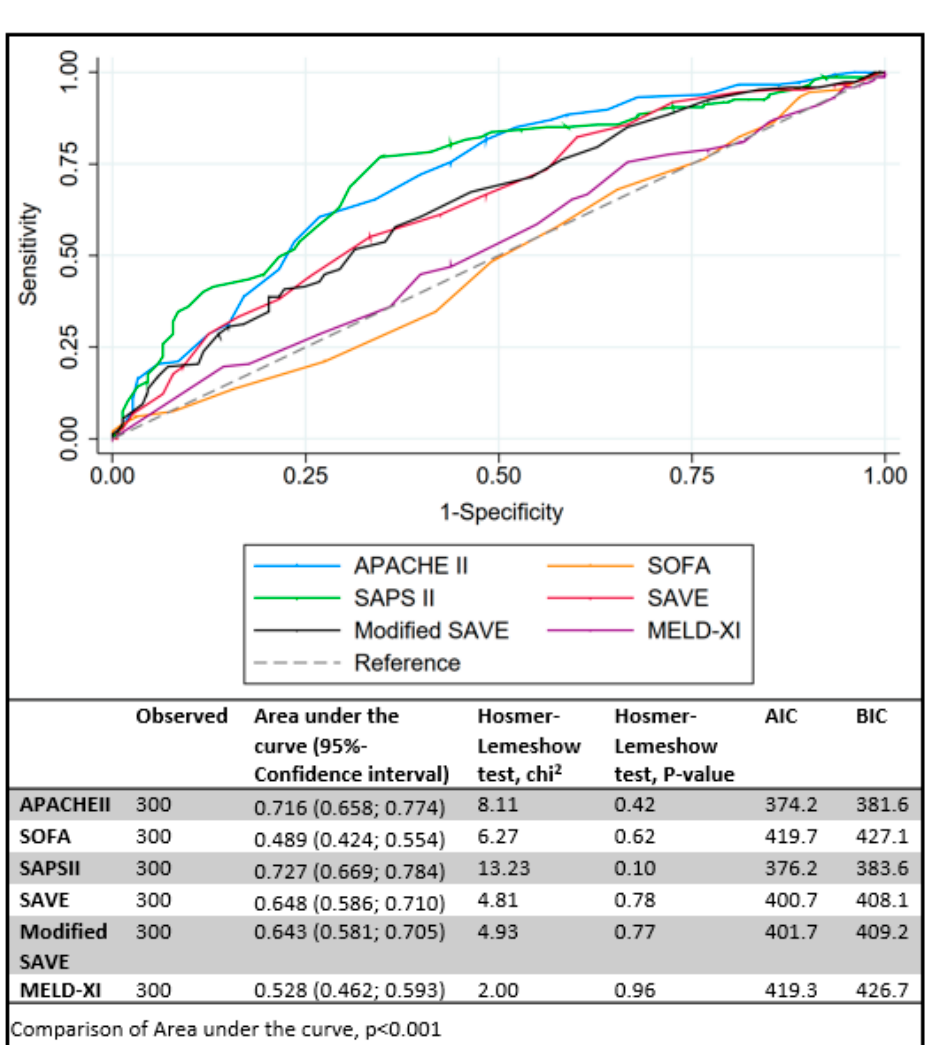
Figure 3. Comparison of area under the receiver-operating characteristics curve (AUC) for (A) veno-arterial extracorporeal membrane oxygenation scores. Akaike and Bayesian Information Criterions (AIC and BIC, respectively).